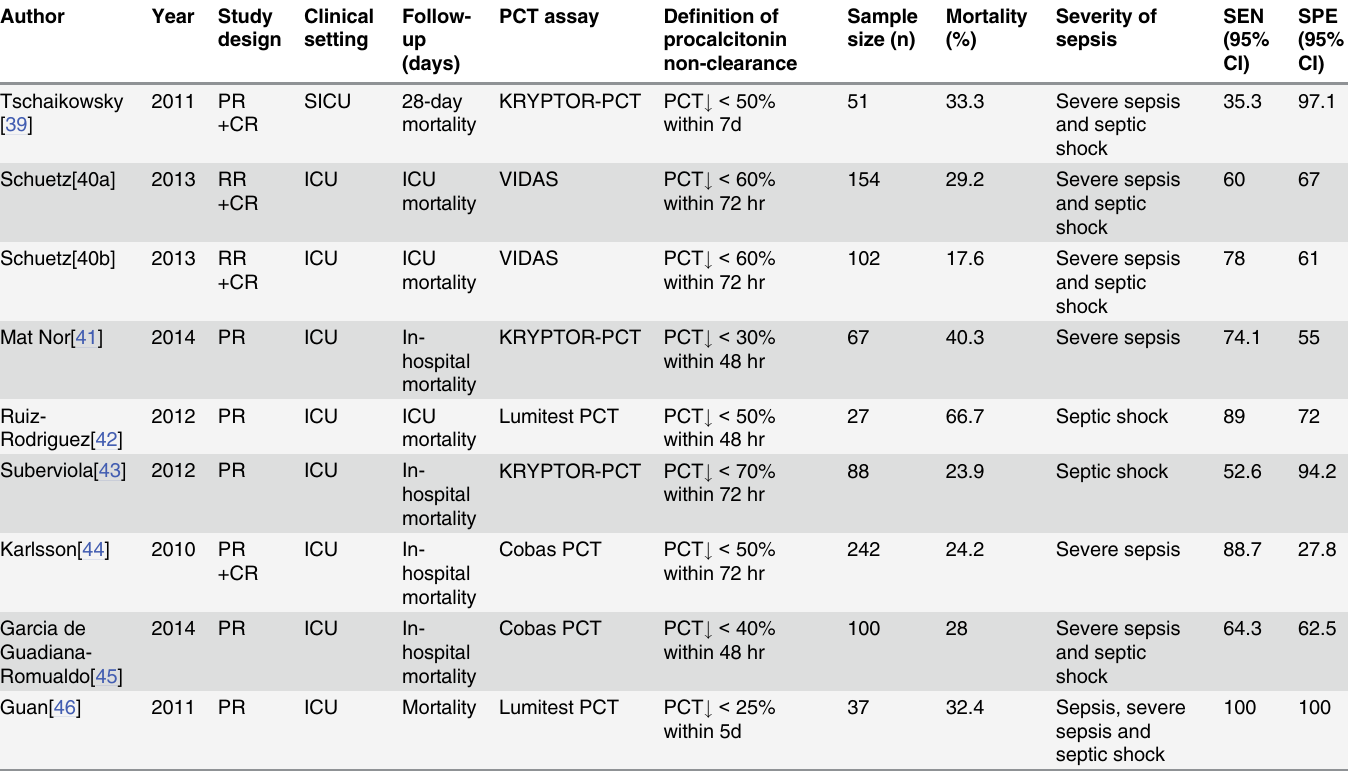
Table 2. Characteristics of studies associating PCT non-clearance with